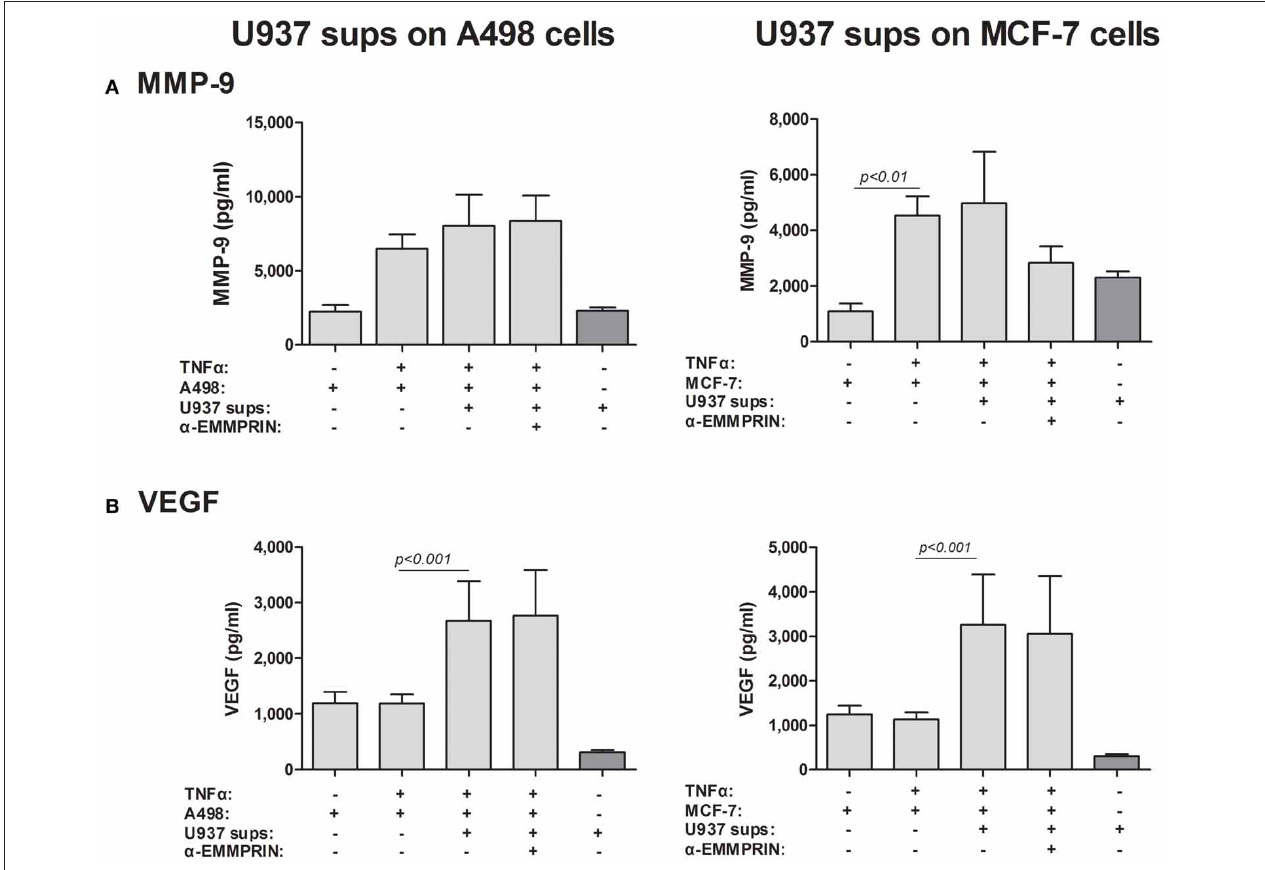
FIGURE 8 | Effect of monocyte supernatants on cancer cell expression of VEGF and MMP-9. 2 × 10 5 A498 or MCF-7 cells were separately incubated in the presence of TNF α (1ng/ml) for 48h with or without the addition of